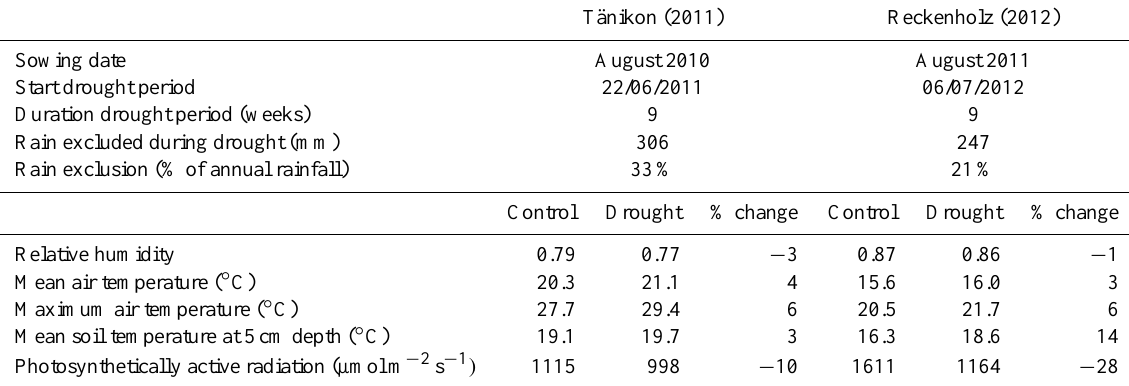
Table 1. Overview of dates and micrometeorological conditions under drought and control treatment during the final week of the drought period in Tänikon 2011 and Reckenholz